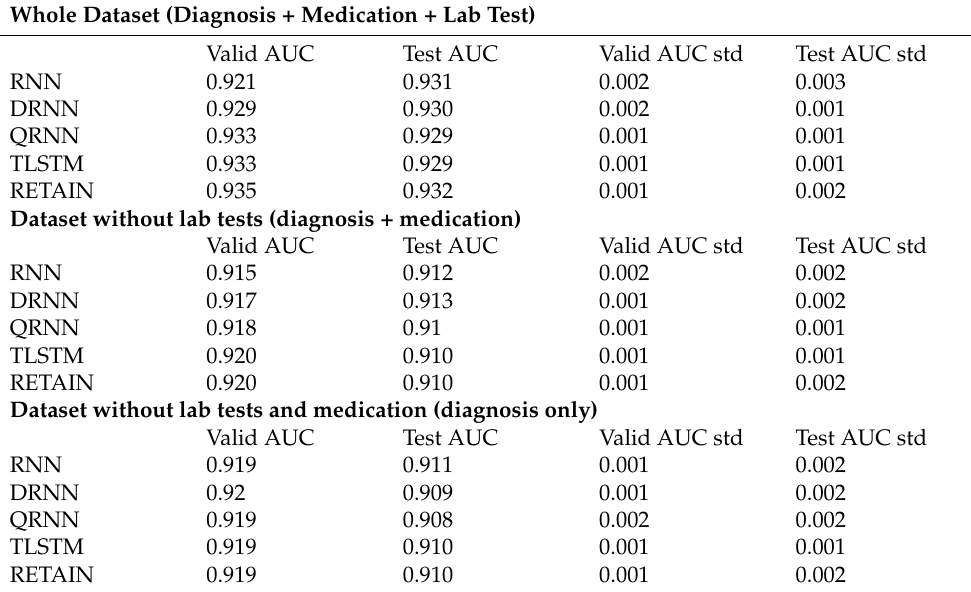
Table 1. The performance of DeepBiomarker with different deep-learning algorithms and features. Whole Dataset (Diagnosis + Medication + Lab